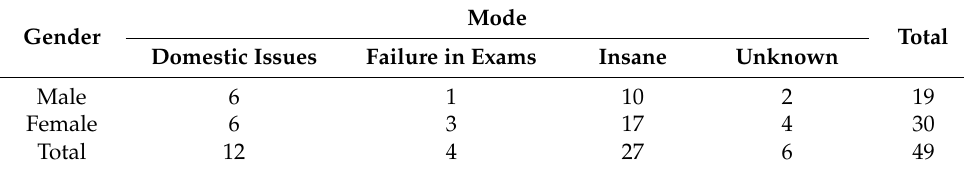
Table 8. Reasons for